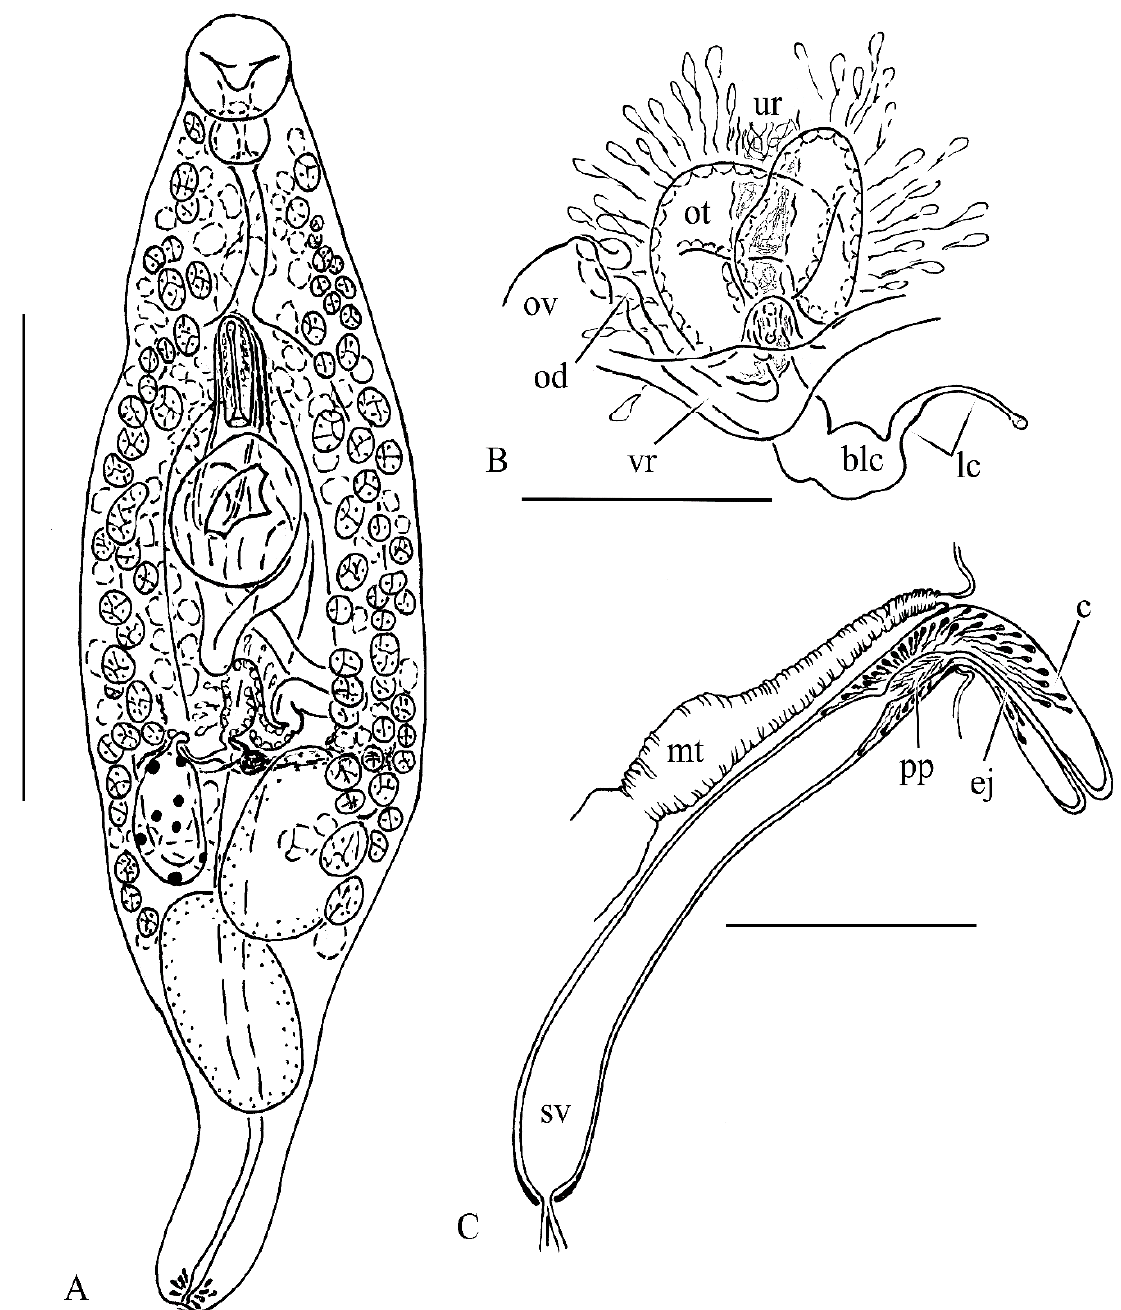
Figure 3. Caudotestis cf. dobrovolski Sokolov, Lebedeva, Shchenkov, and Gordeev, 2020 from intestine of Falcate snailfish Careproctus cypselurus (Jordan and Gilbert, 1898) (Liparidae), the Sea of Okhotsk. ( A ), whole mounted specimen, ventral view; ( B ), ovarian complex, ventral view; ( C ), terminal genitalia, lateral view. Abbreviations: blc, proximal dilation of Laurer’s canal; c, evaginated cirrus; ej, ejaculatory duct; lc, Laurer’s canal; mt, metraterm; od, oviduct; ot, oötype with Mehlis’ gland cells; ov, ovary; pp, pars prostatica with field of prostatic cells; sv, seminal vesicle; ur, uterine seminal receptacle; vr, vitelline reservoir. Scale bars ( A ) = 1000 µ m; ( B , C ) = 200 µ m. Description (based on 13 whole mount adult specimens—paragenophores). Body fusiform, length 1946–2933 (2374), maximum width 490–742 (661) in posterior quarter of anterior half or middle of body. Forebody 28.8–33.9 (32.3)% of body length. Tegument smooth. Oral sucker trapezoid or round, 159–228 × 180–256 (198 × 208). Ventral